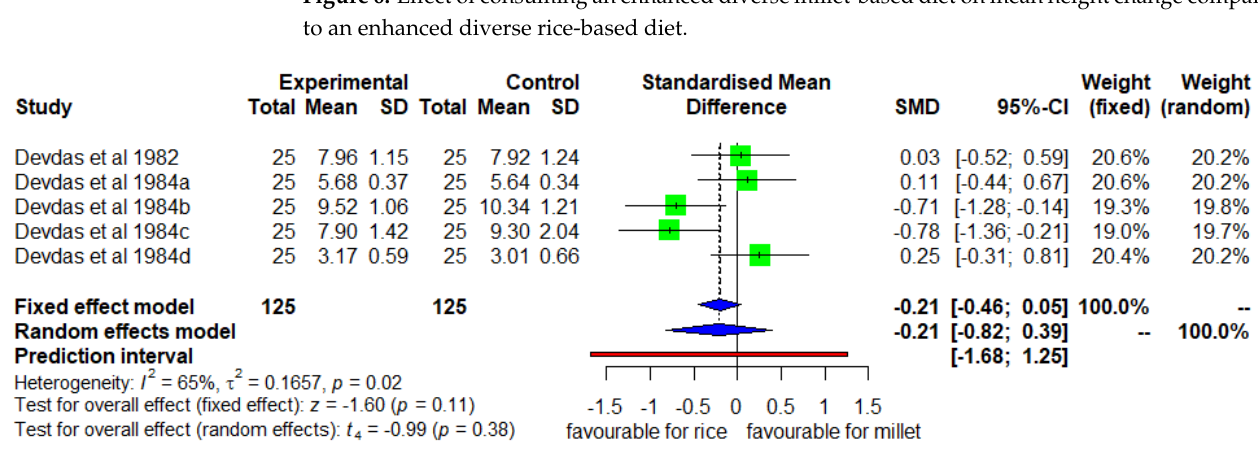
Figure 6. Effect of consuming an enhanced diverse millet-based diet on mean height change com- pared to an enhanced diverse rice-based diet.